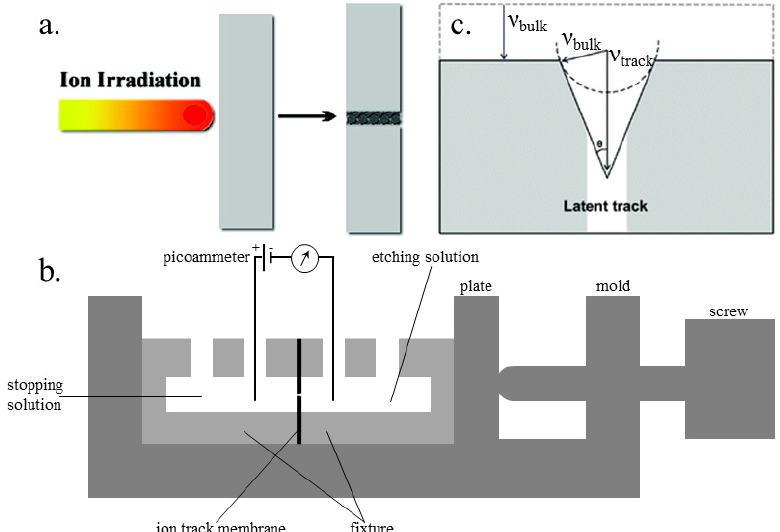
Figure 1. Schematic illustration of a nanochannel fabrication. ( a ) Origin of ion tracks.